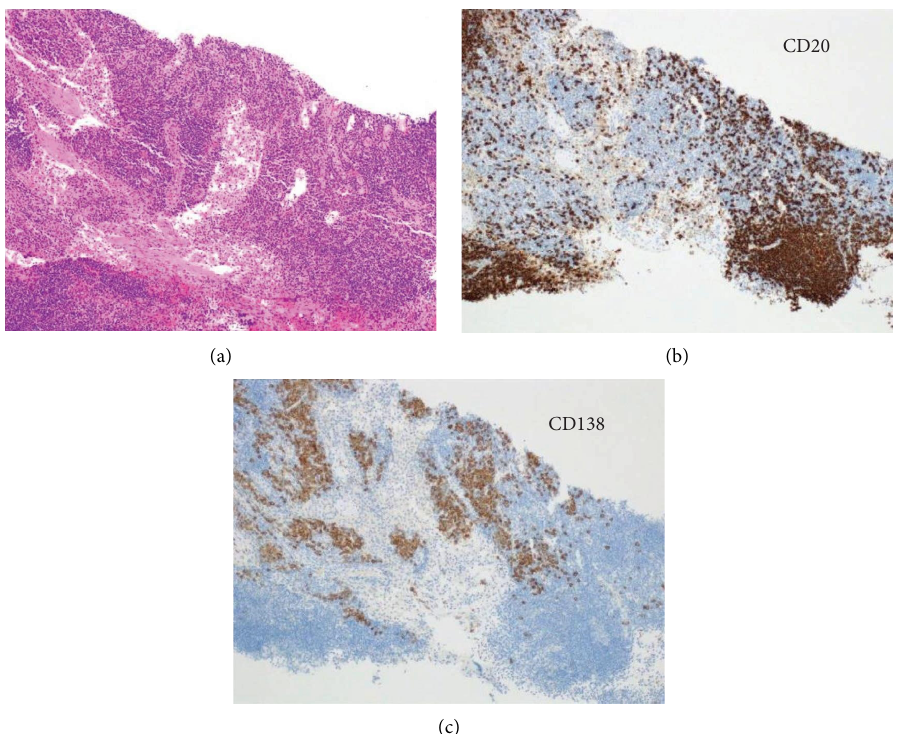
Figure 2: Lymph node pathology. Light microscopic appearance of inguinal lymph node obtained by needle biopsy reveals difuse interfollicular plasma cell infltration (hematoxylin and eosin staining (HE)) (a). As hyaline vascular proliferation was not evident, this case present plasma cell type of MCD. Immunohistochemistry reveals CD20-positive lymphocytes in the follicular region (b), while signifcant CD138-positive plasma cells exist in the interfollicular region